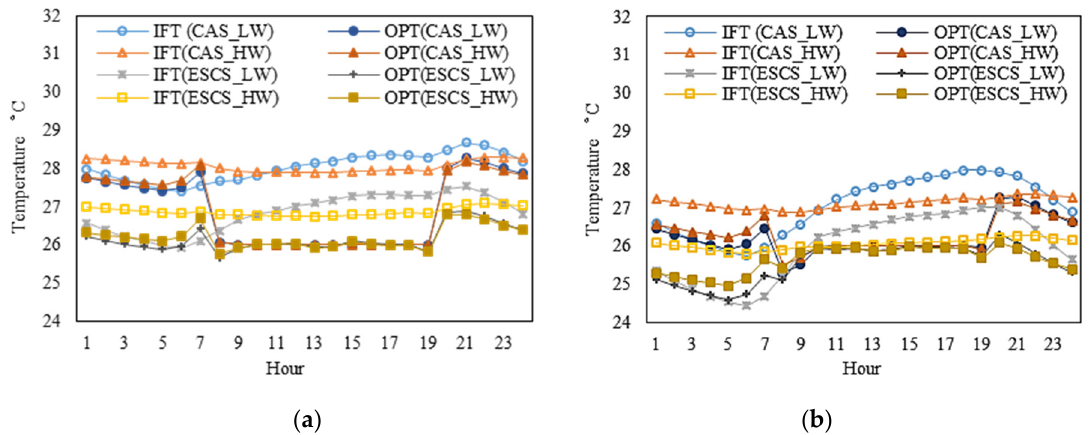
Figure 8. Indoor temperature in the north perimeter zone. ( a ) Indoor temperature on a Beijing cooling design day. ( b ) Indoor temperature on a typical Nanjing day in transient season. (IFT—indoor face temperature, OPT—operative temperature).